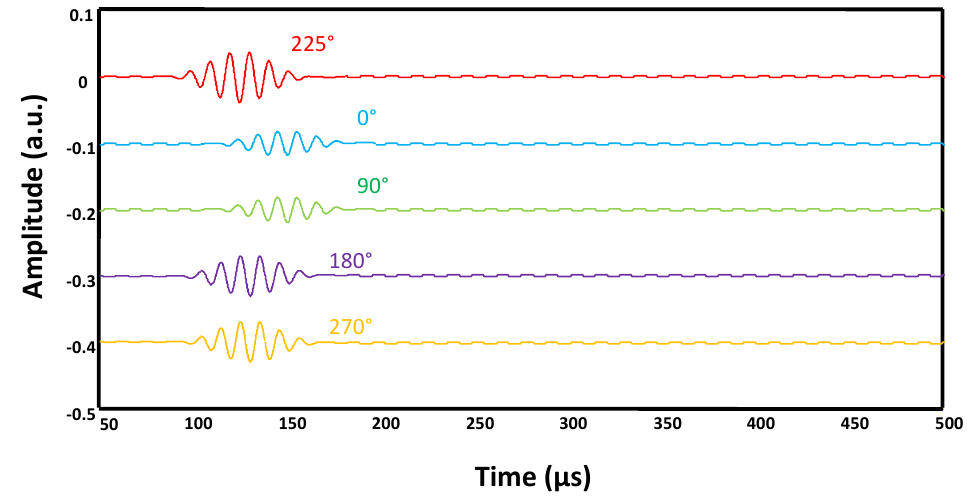
Figure 9. Reconstructed signal from the FE model at some angular positions 20 mm away from the center of impact damage.